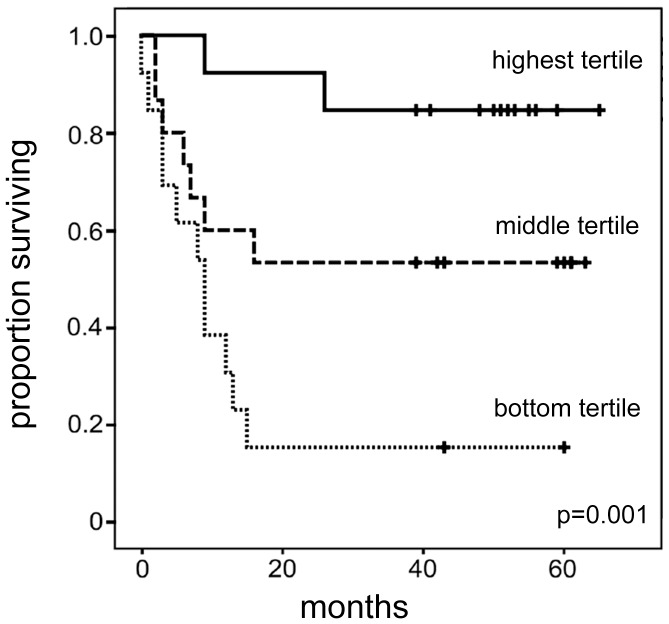
Kaplan-Meier estimates of cancer-specific survival in RCC patients according to SePP serum concentrations.RCC patients (n = 41) were categorized into relatively high, moderate or low Se status by calculating tertiles of serum SePP as a reliable circulating biomarker (highest tertile: [SePP] >2.7 mg/l; middle tertile: [SePP] = 2.4–2.7 mg/l; bottom tertile: [SePP] <2.4 mg/l). Low Se status as reflected by serum SePP concentrations in the bottom tertile at time of diagnosis is associated with poor survival odds.